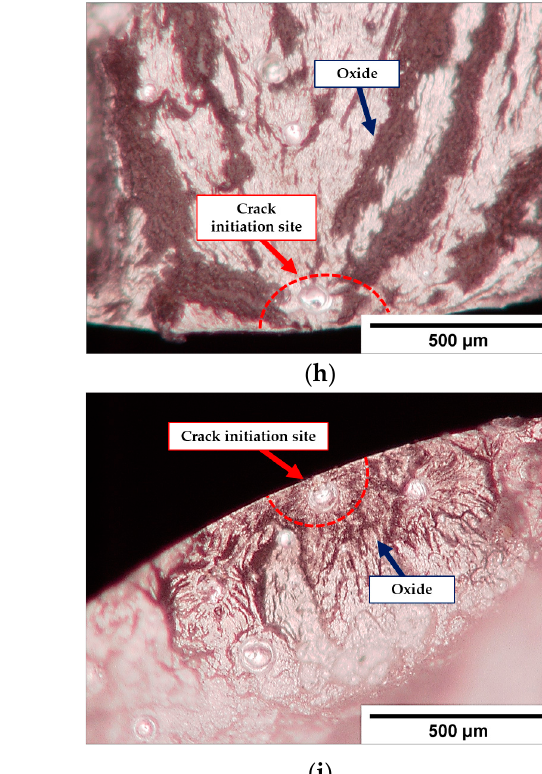
Figure 10. Low magnification multi ‐ focus images for T5 ‐ RT ( a , b ), T5 ‐ 200T ( c , d ), T6R ‐ RT ( e , f ), and T6R ‐ 200T ( g – i ). Fracture surface regions of interest: (i) crack initiation, (ii) crack propagation, and (iii) final overload fracture.